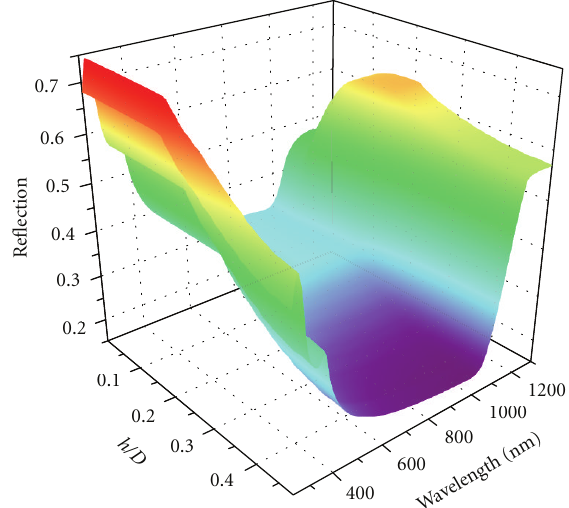
Figure 5: Reflection, R m , as a function of rear surface reflection, ff erent wavelengths of incident light. The values of h / D R R m , for di and wafer thickness used in simulation were 0.25 and 200 μ m respectively.